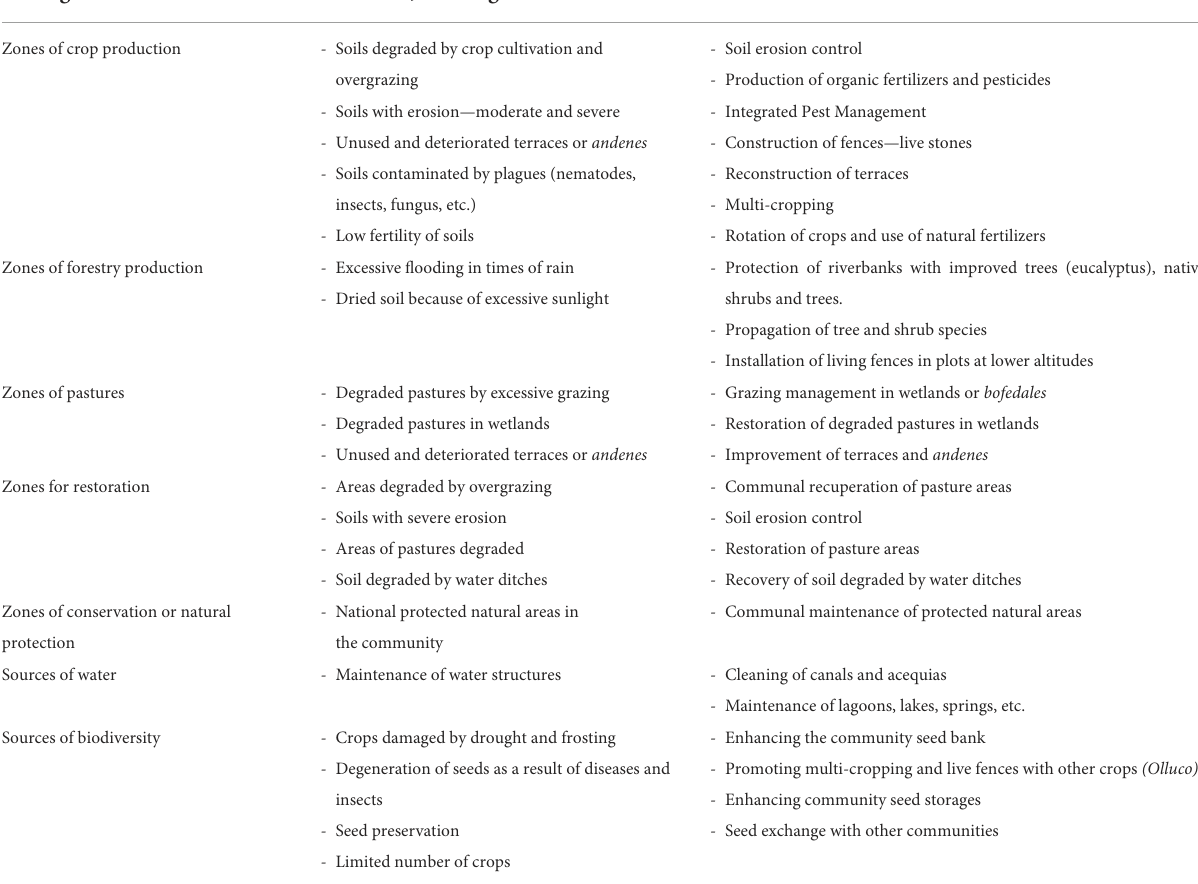
TABLE 5 Identification of problems and